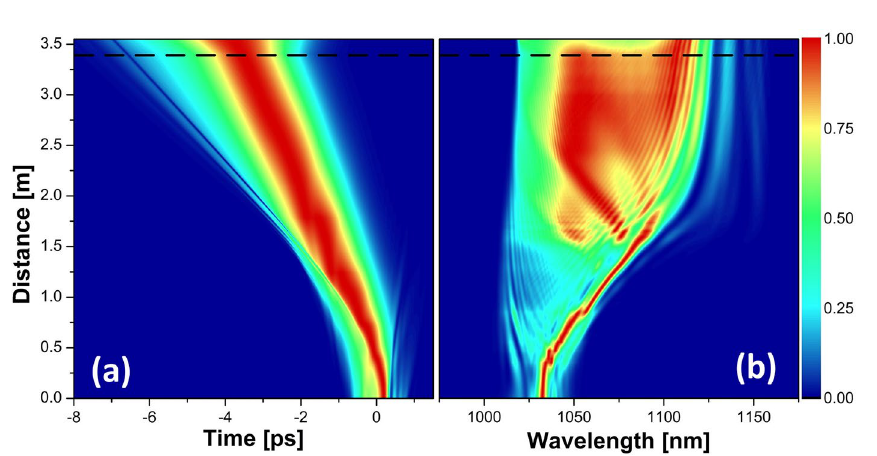
Figure 9. Evolutions of the normalized temporal ( a ) and spectral ( b ) intensities at the 4.4 W of pump power for the low-repetition-rate laser as a seed source. The dashed black line shows the splice between active and passive